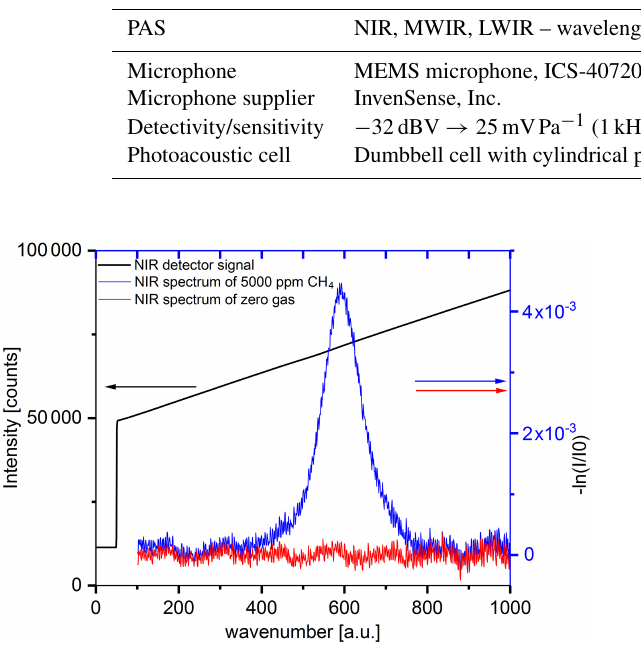
Figure 3. NIR raw and baseline-corrected absorbance data. Left scale: detected laser intensity as a function of the laser current ramp. The intensity dip due to the CH 4 absorption is not visible in this scale. Right scale: calculated absorbance spectrum after baseline correction for 5000ppm CH 4 and zero gas (dry N 2 ).